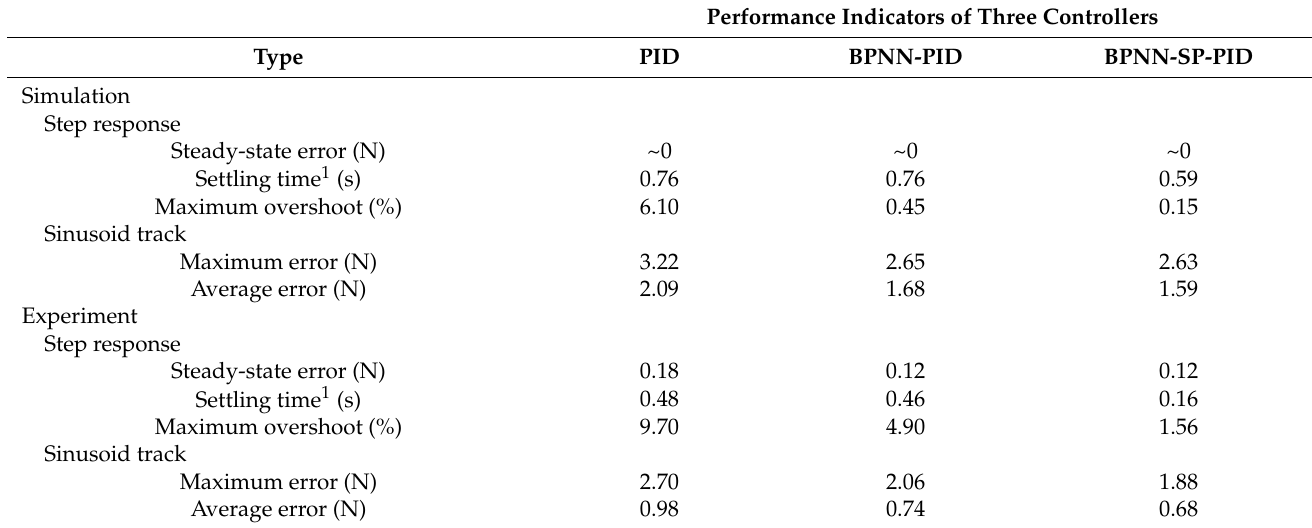
Table 3. Comparison of overall performance indicators of three